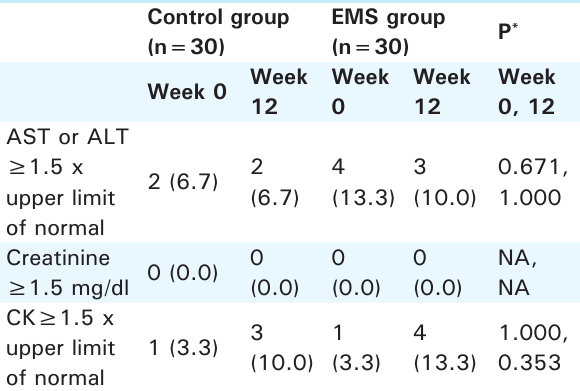
Table 4. Abnormal clinical findings at baseline and at study